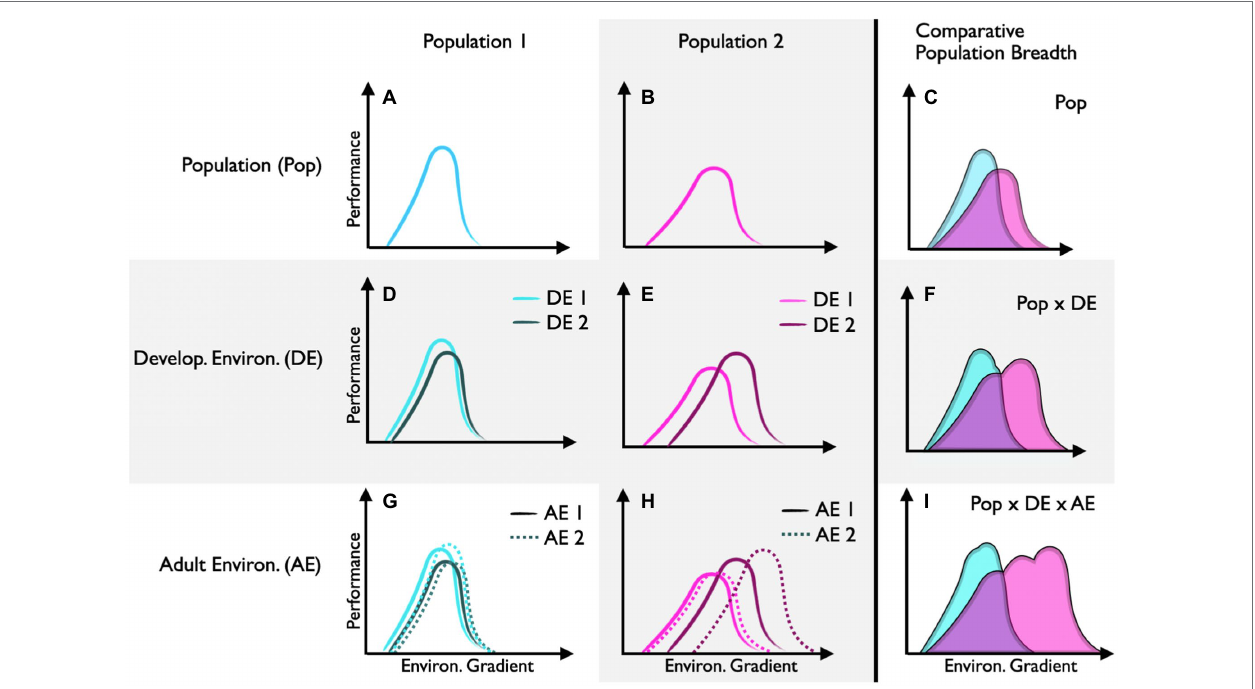
FIGURE 3 | Performance curve shifts between and within populations. Performance curves for population 1 (A) and population 2 (B) are shifted (C) , suggesting that each population is locally adapted (assuming common-garden conditions). Population 1 has low capacity for developmental plasticity (D) , whereas population 2 has high capacity for developmental plasticity (E) , which increases its potential performance breadth (F) . Population 1 has low capacity for reversible acclimation regardless of the developmental environment (G) . Population 2 has high capacity for reversible acclimation, but only when individuals develop in environment 2 (H) . This relatively high capacity for reversible acclimation further increases the potential performance breadth of population 1 (I)